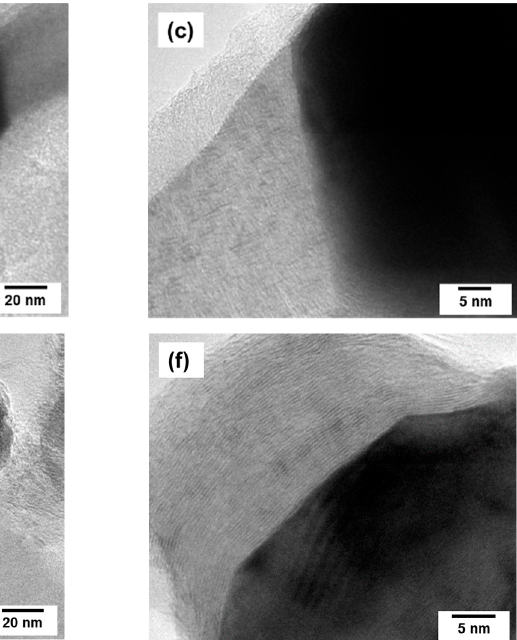
Figure 8. TEM images of Pt 1 − x Ni x /CNF composites obtained via ethylene decomposition at 600 °C: ( a – c ) x = 0.50, t = 15 min, Y CNF = 3.6 g/g cat ; ( d – f ) x = 0.80, t = 4 min, Y CNF = 4.3 g/g cat .